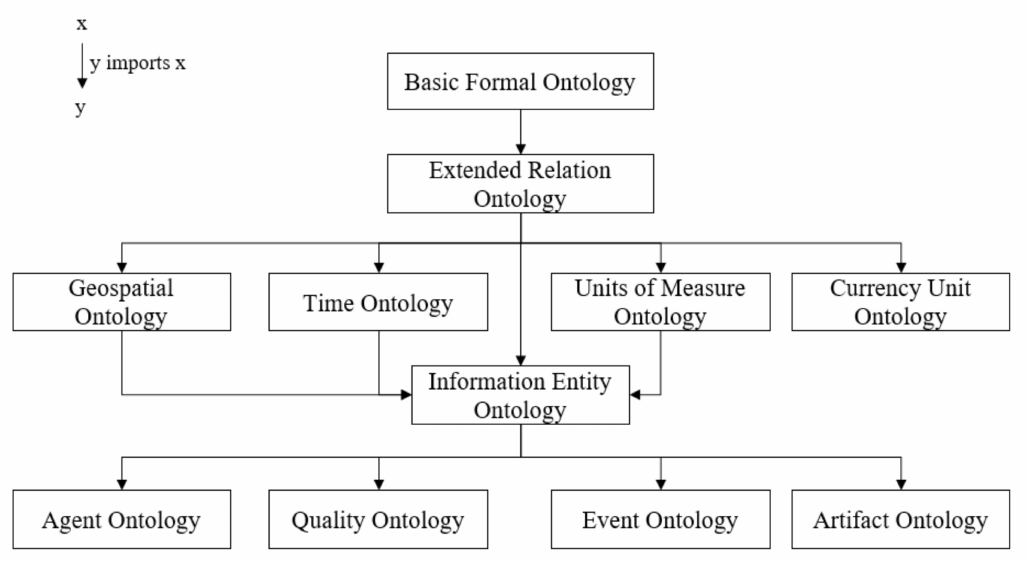
Figure 5. CCO modules hierarchy